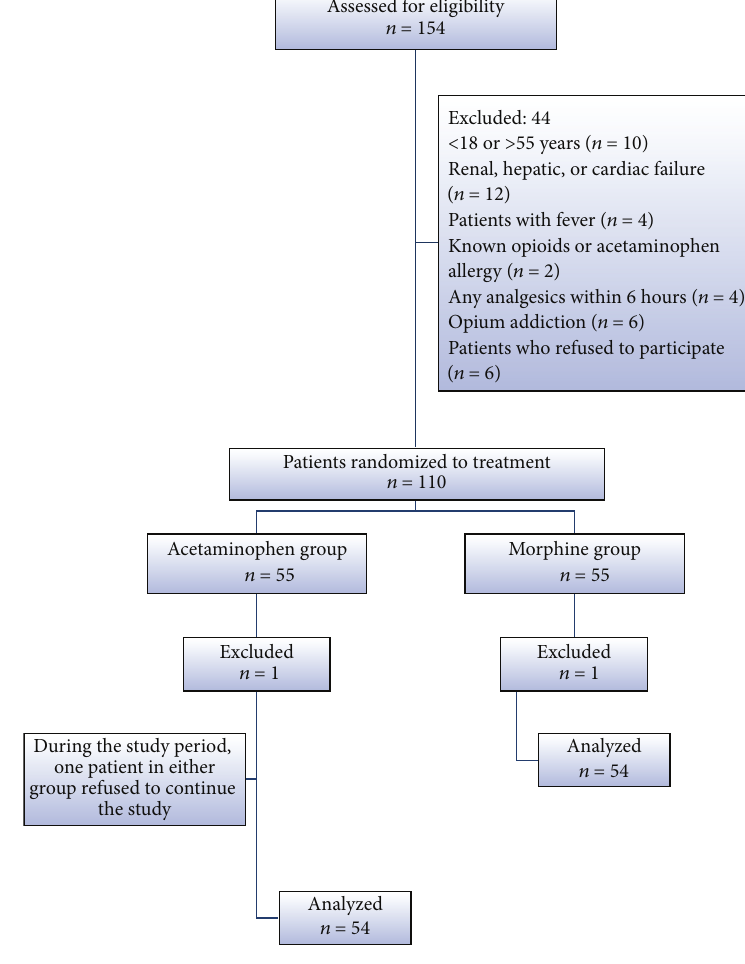
Figure 1: Patient flowchart.